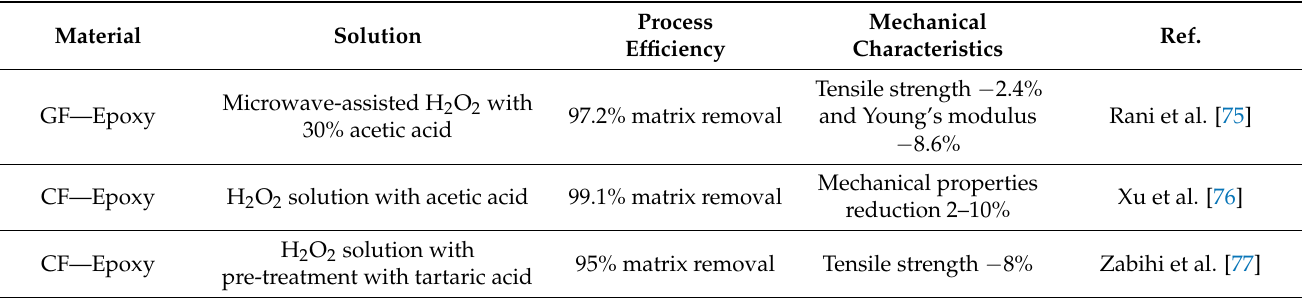
Table 3. Main results deriving from acid